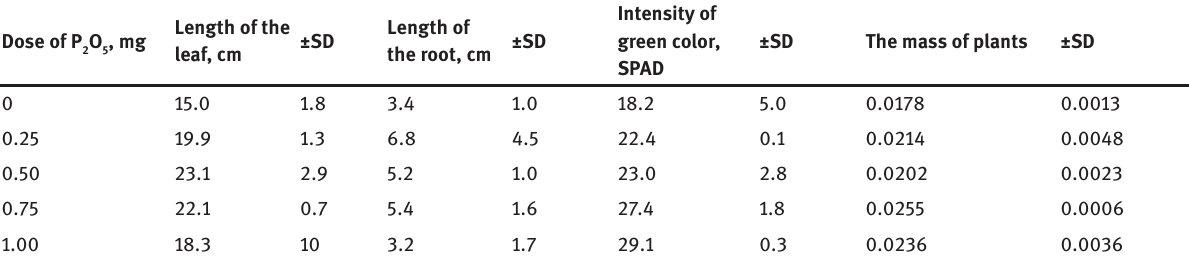
O dose for hydroponic test 2 5